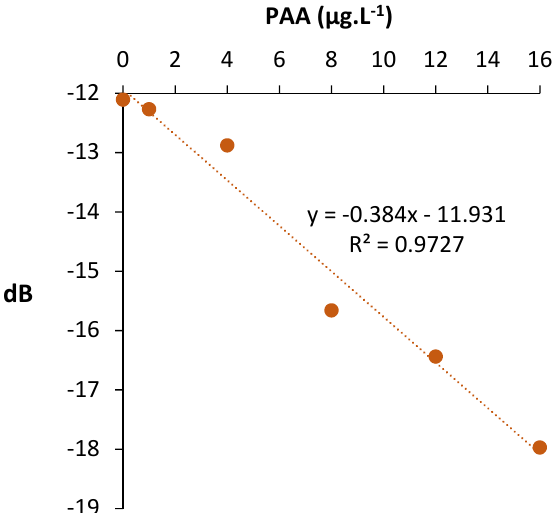
Figure 6. Effect of PAA concentration on the response of the MIS-microwave sensor in red wine at 2.4 GHz. Uncertainty on dB = 1%. The correlation coefficients for linear correlation are over the critical values of the Pearson’s correlation coefficient in a one-tailed test at the level of significance of 1%. 6 points, 4 degree of freedom, R critical value = 0.882 < R observed = 0.986.